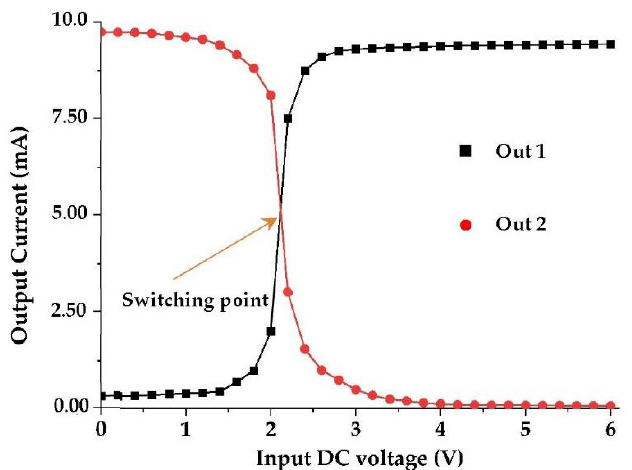
Figure 25. Measured DC output currents (Out1, Out2) of the proposed switch.